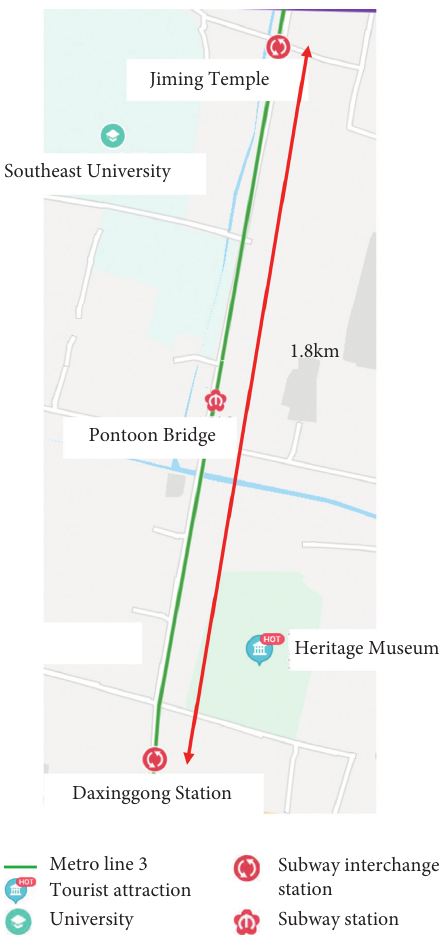
Figure 9: Artery road to be